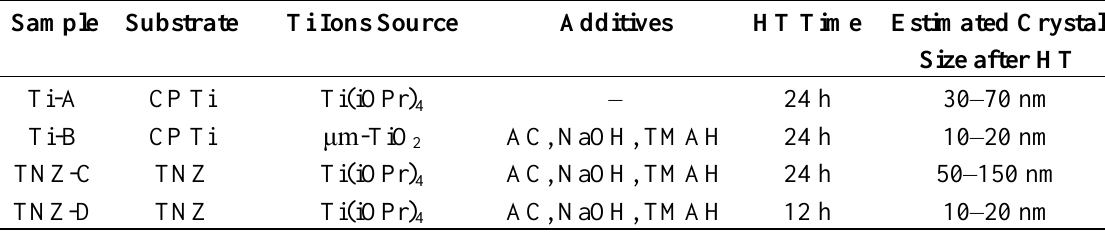
Table 1. Summary of the synthesis conditions and information about the titania grown crystals for samples Ti-A, Ti-B TNZ-C and